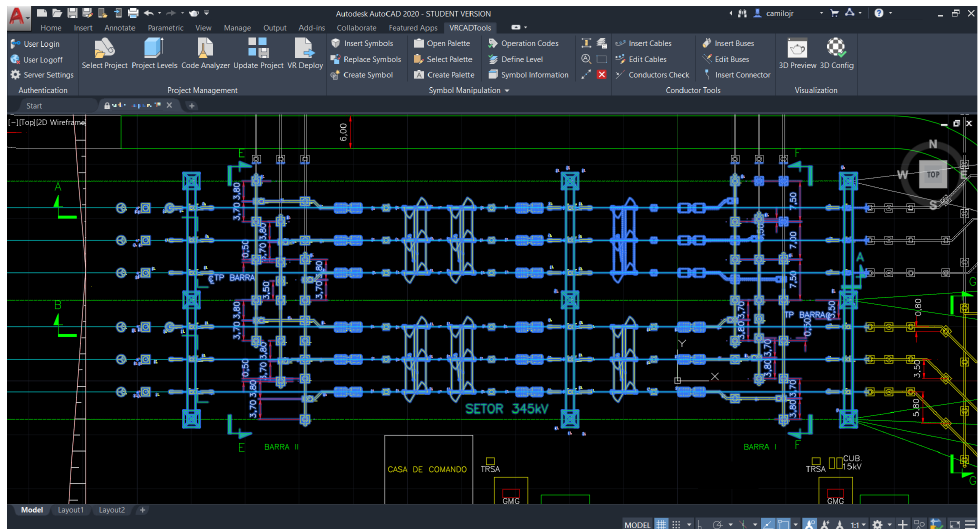
Figure 16. Design of the floor plan of the EPS produced using the CAD